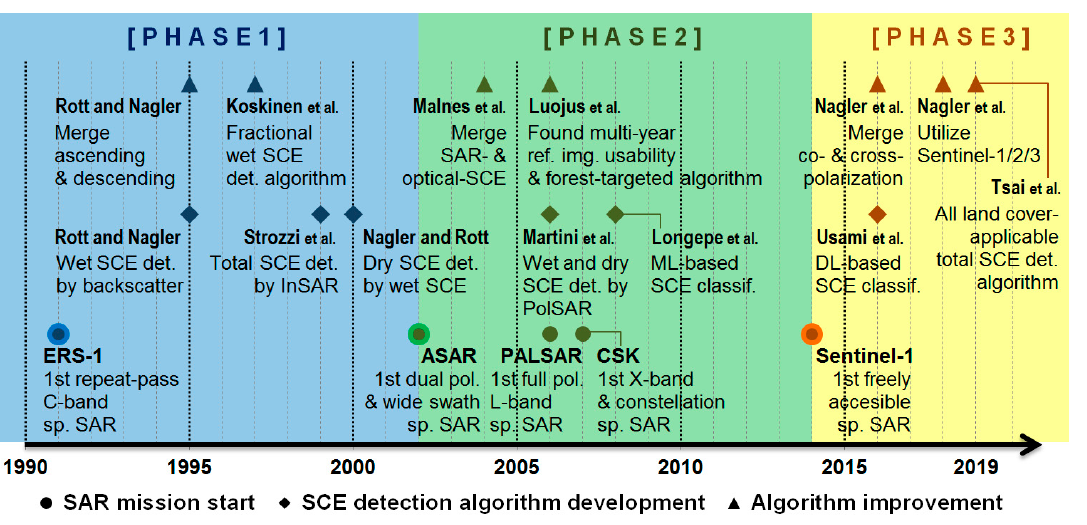
Figure 12. Overall development of algorithms and methods relying on spaceborne SAR data for snow cover extent (SCE) detection. The three phases denote the different main algorithms based on available SCE detection algorithms and SAR data.